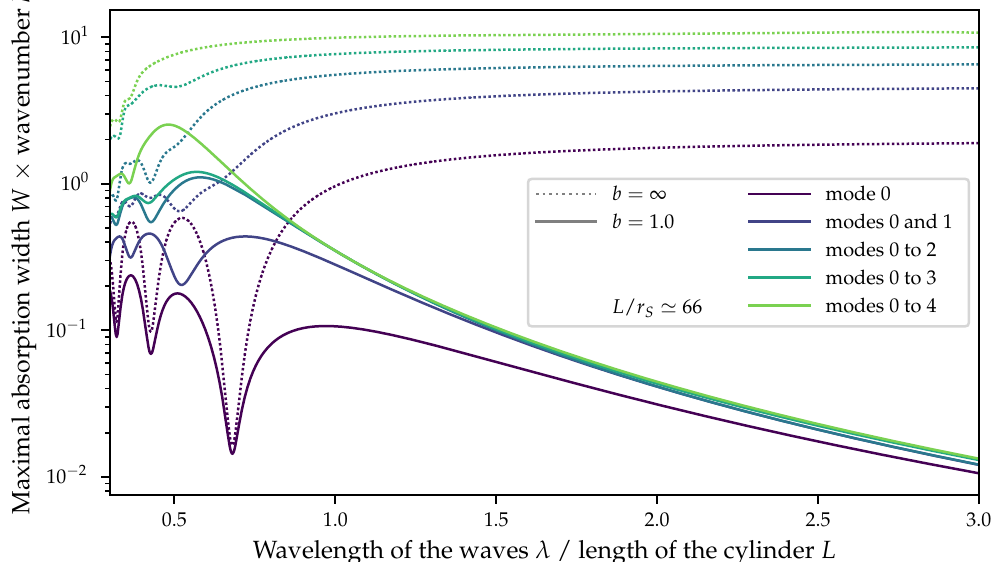
Figure 6. Dimensionless maximal absorption width as a function of the wavelength of the incoming waves. Each line corresponds to the absorption width for the combination of several modes. The dotted lines are the unconstrained absorption widths. The solid lines are the absorption widths under the constraint b =